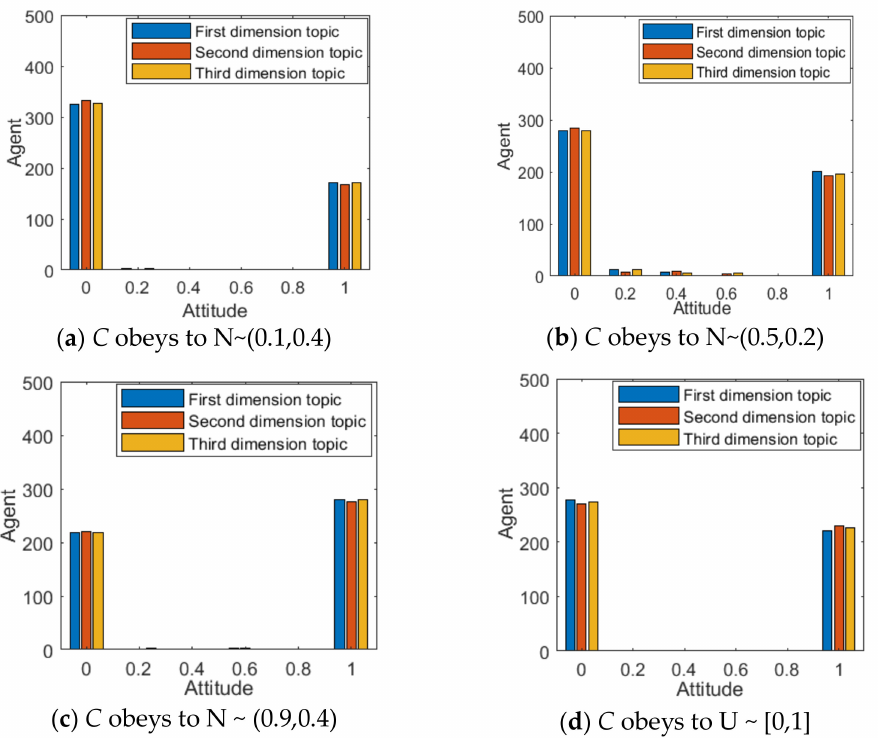
Figure 8. Histogram of group attitude distribution under individual view confidence with different distributions.